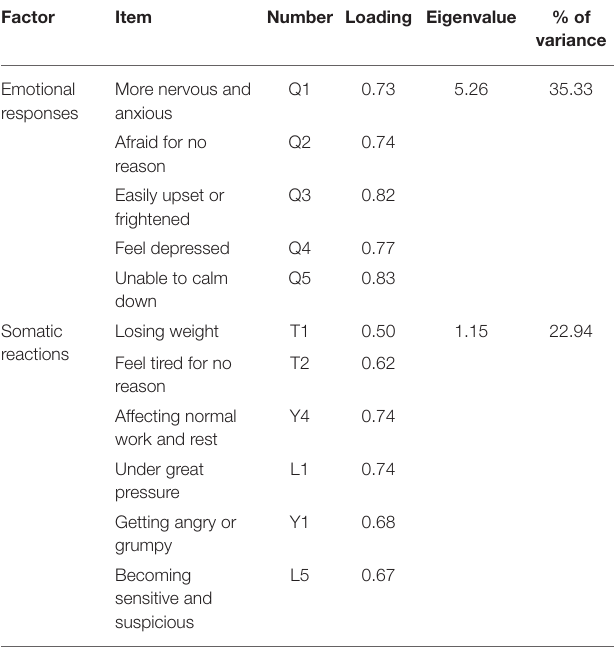
TABLE 4 | Evaluation of questionnaire